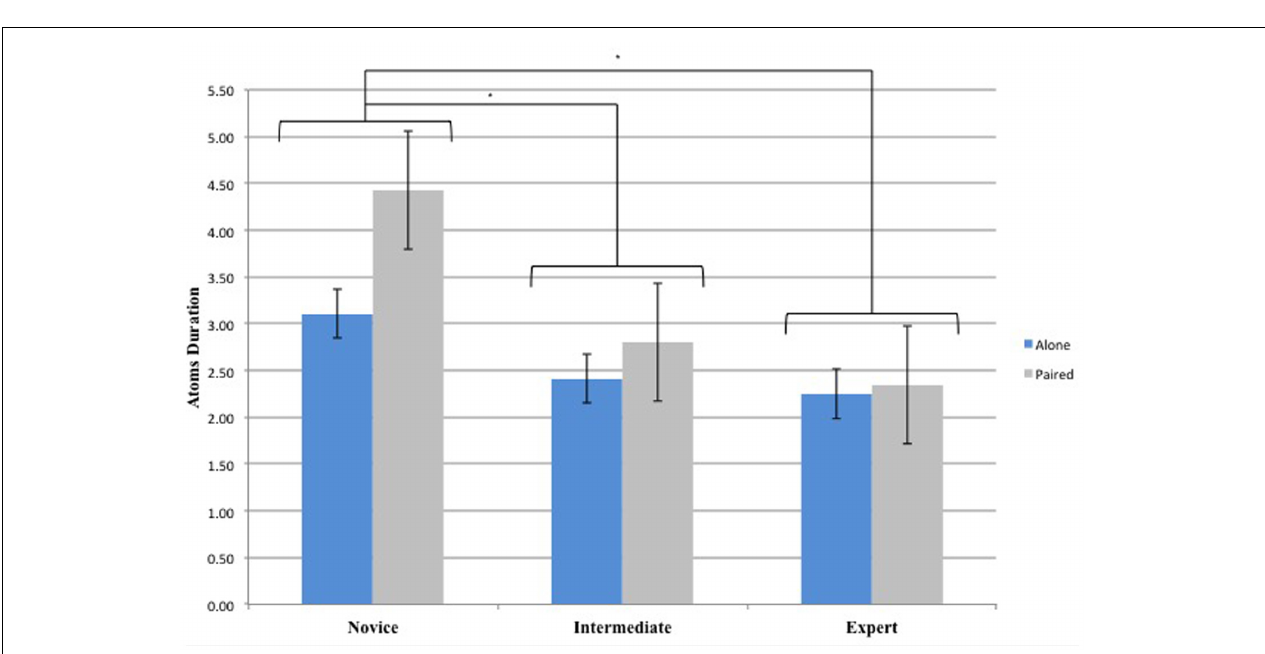
FIGURE 4 | Number of Atoms for the 3 Groups (Novice, Intermediate, and Expert) and the 2 Conditions (Alone and Paired).